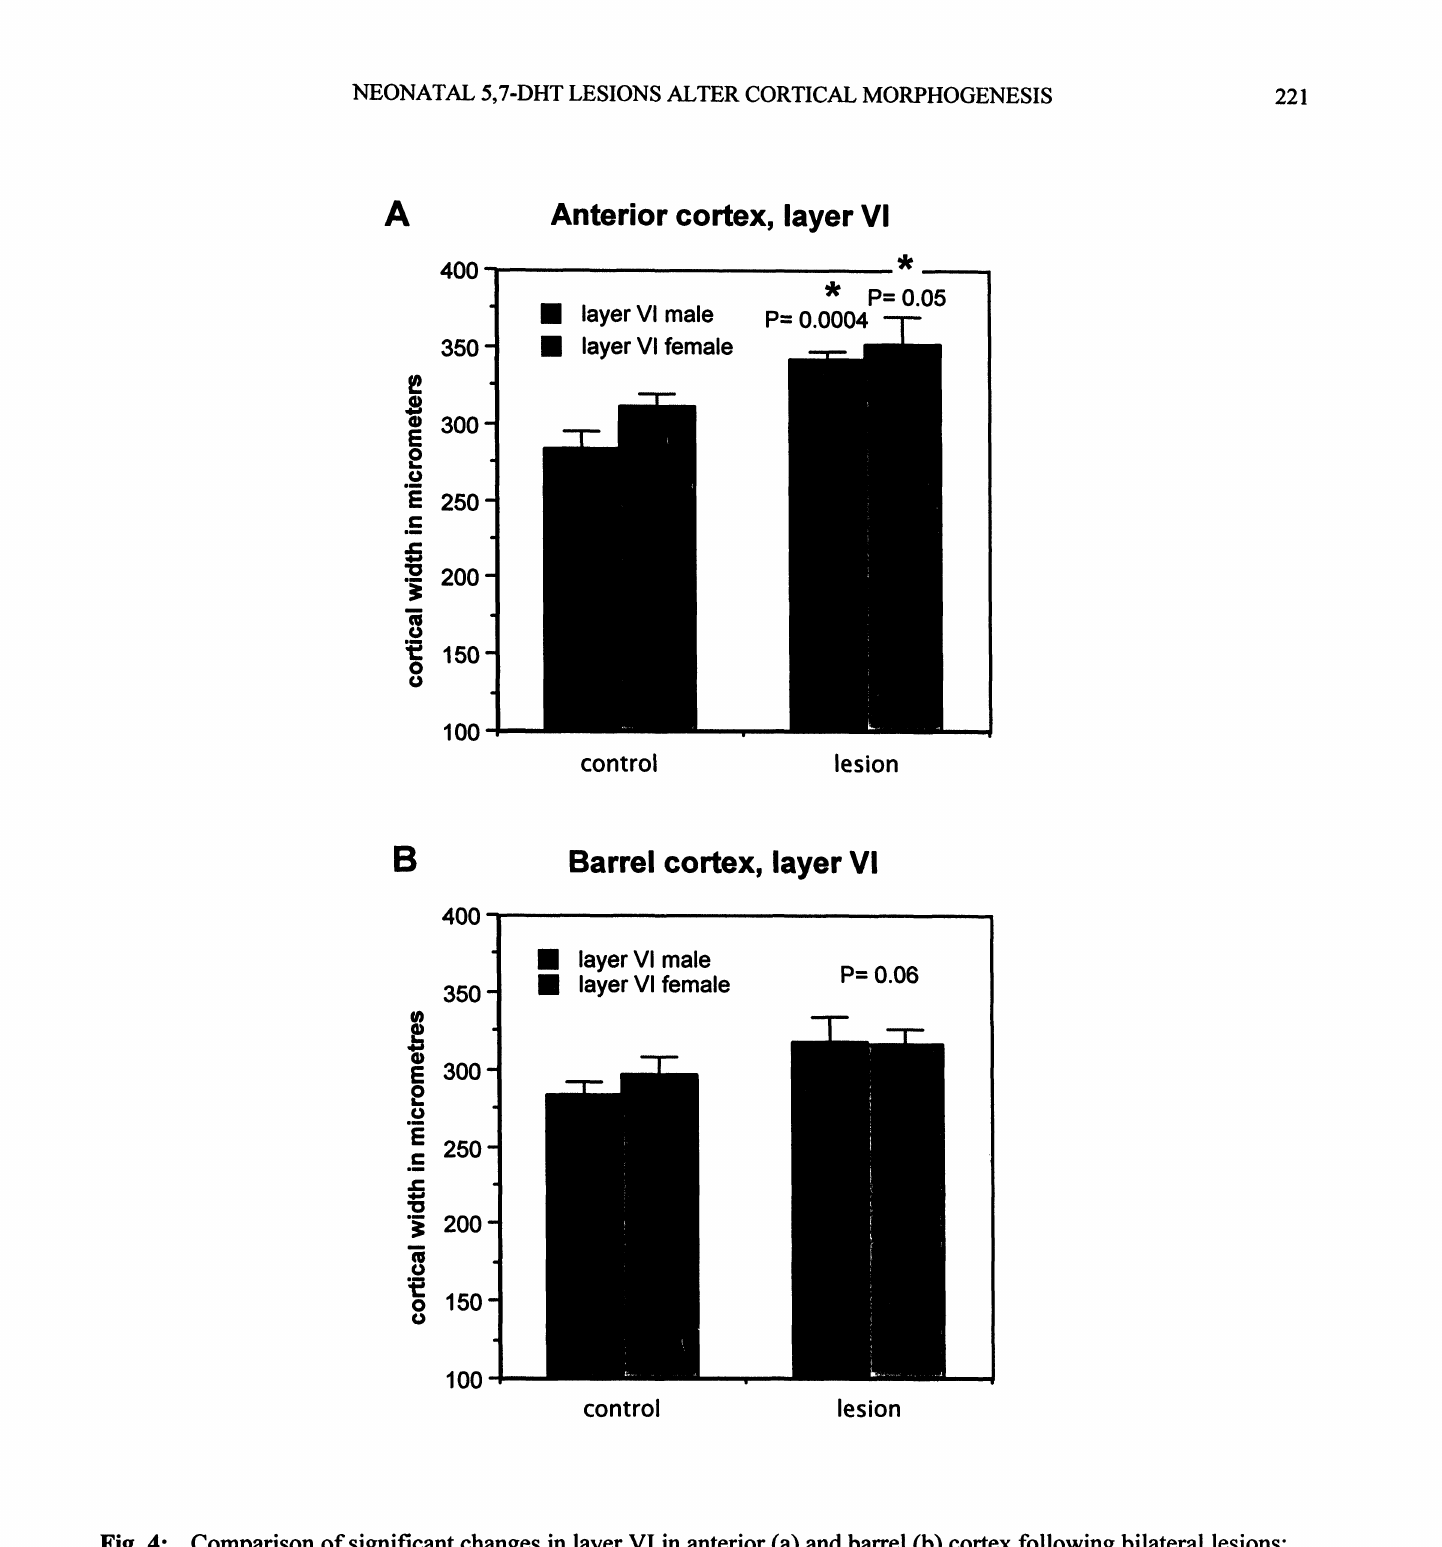
Comparison of significant changes in layer VI in anterior (a) and barrel (b) cortex following bilateral lesions; * denotes significant lesion related differences. As before, males are more prominently affected in anterior cortex and sex differences are attenuated by the